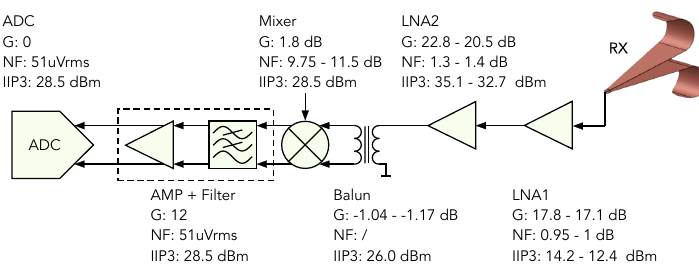
Figure 7. SFCW GPR detailed Radio Frequency (RF) front-end block